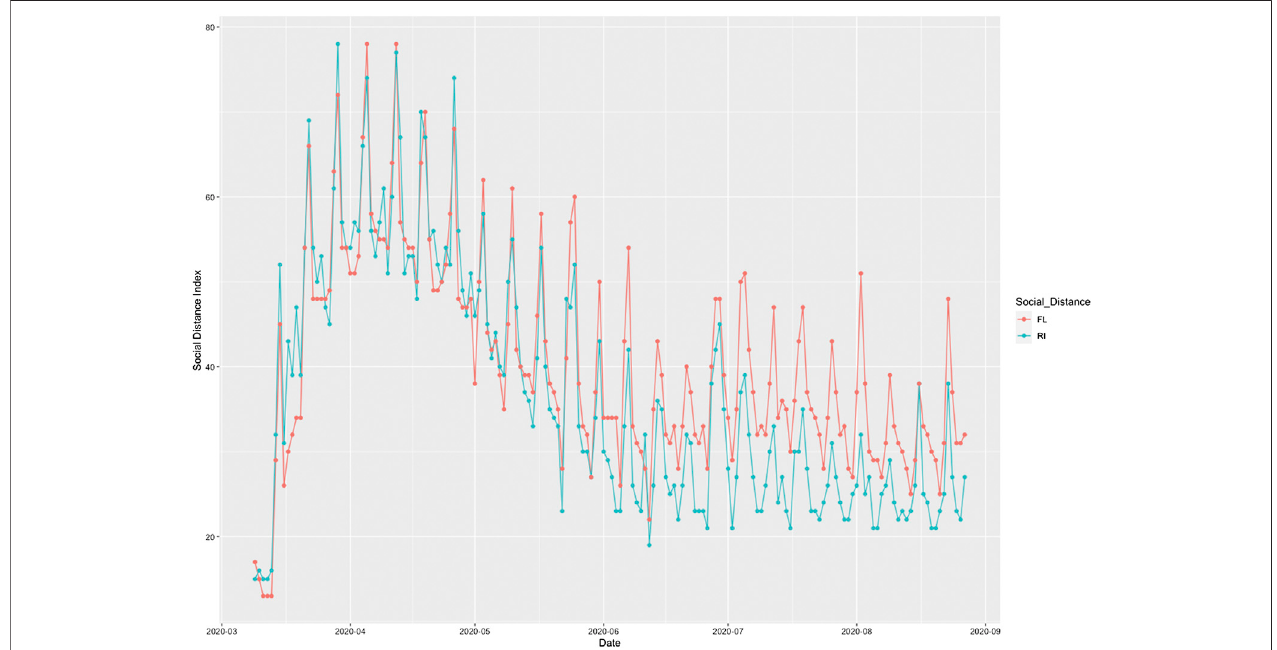
FIGURE 1 | Social distance index curves as a function of time from March 5, 2020 to August 25, 2020 in Florida (FL) (red color) and Rhode Island (RI) (blue color).